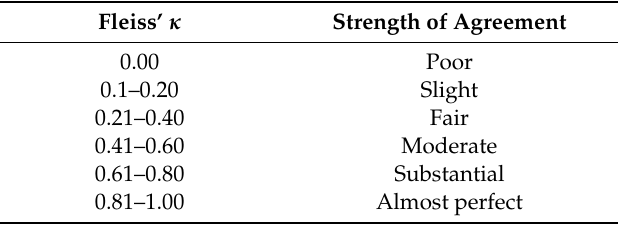
Table 3. Fleiss’ κ values and strength of agreement